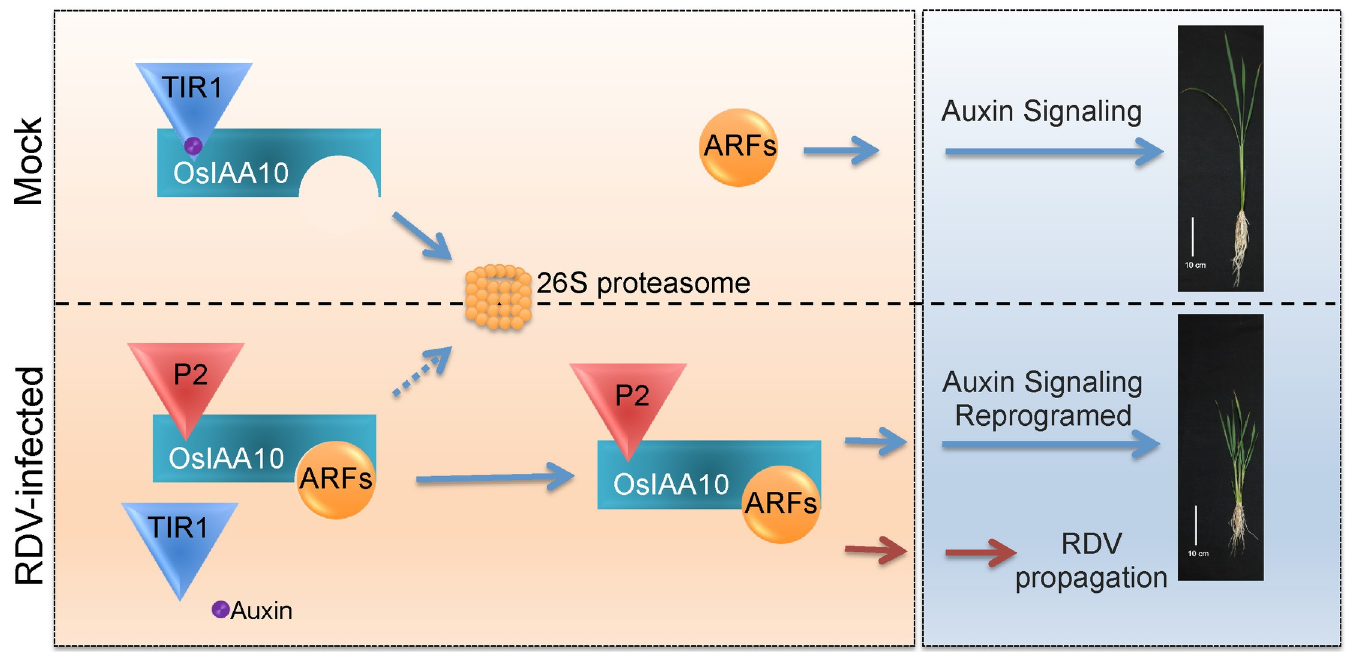
Fig 7. Proposed model. In mock rice plants, high auxin concentration promotes the interaction between OsIAA10 and OsTIR1, leading to the ubiquitination and 26S proteasome degradation of OsIAA10, releasing the specific OsARFs. Then genes of auxin signaling pathway were adequately regulated by corresponding ARF transcription factors, promoting normal rice growth. Under RDV infection condition, P2 binds to the domain II of OsIAA10, blocking its association with OsTIR1 for degradation. The stabilized OsIAA10 binds to corresponding OsARFs, manipulating down-stream gene expression in the auxin signaling pathway. Reprogramed auxin signaling causes stunting, more tillering, shorter crown roots to the rice plants and promotes RDV propagation in rice.